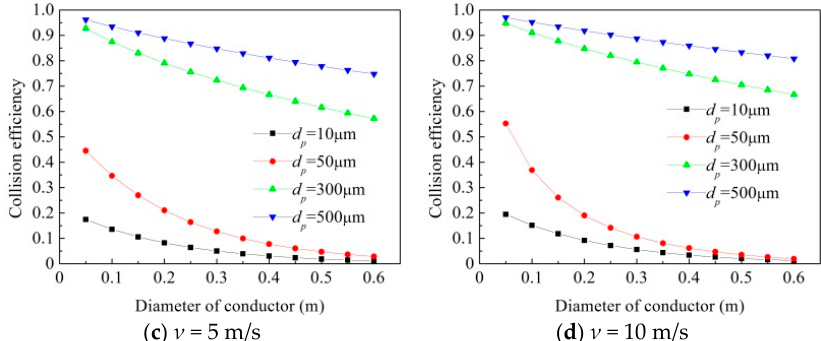
Figure 5. Collision efficiency of the water droplets with the different diameters of conductors.